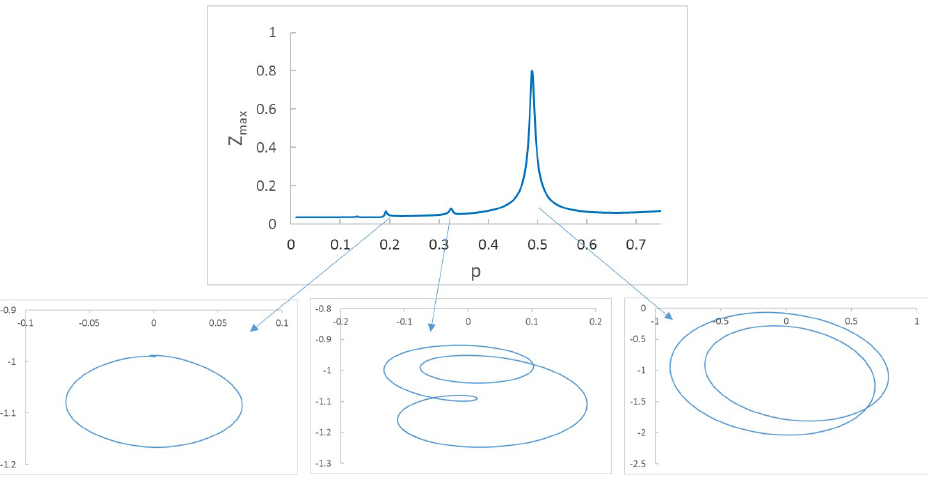
Figure 5. Peaks in sweep and orbits for α =